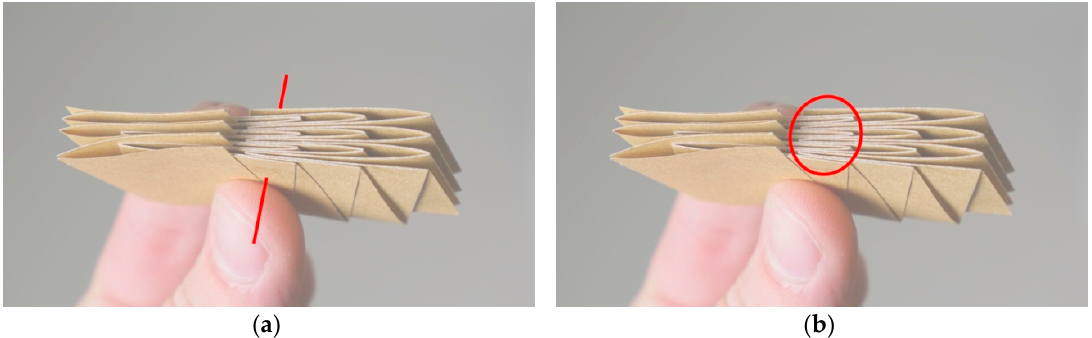
Figure 9. Folded state of a Miura-ori pattern. The red line in ( a ) shows the location with the highest number of overlapping sheets of paper. The red ellipse in ( b ) displays the location where the highest number of edges or creases are exactly stacked onto each